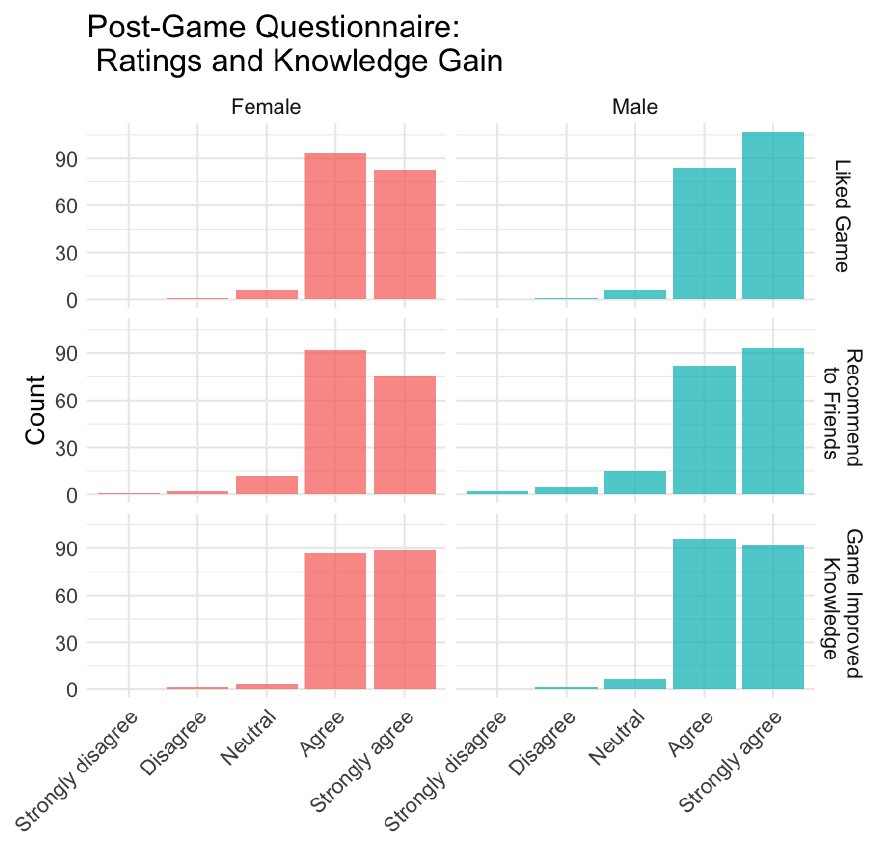
Figure 7. Quality-of-game responses from post-game